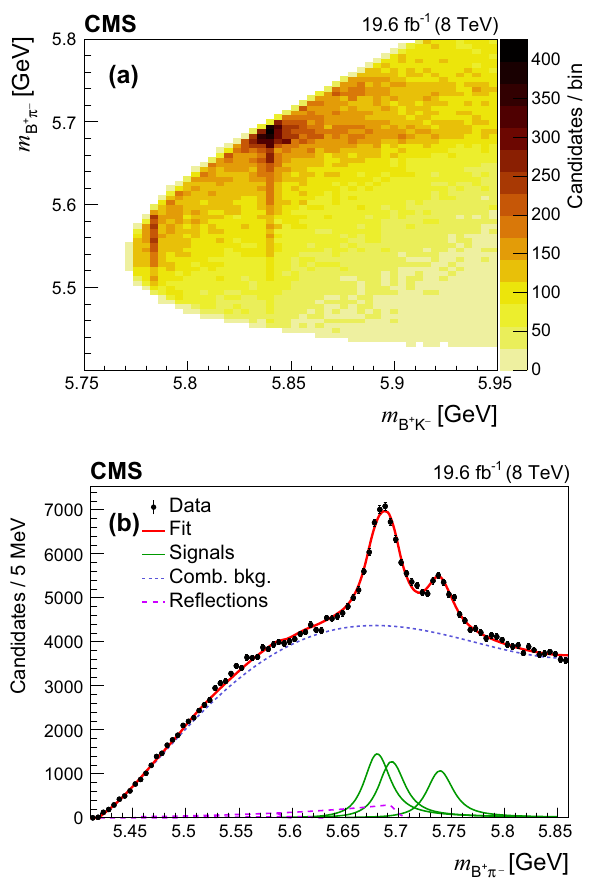
Fig. 2 a Two-dimensional distribution of m B + K − versus m B + π − in data. b The fitted B + π − invariant mass distribution. The points rep- resent the data, the thick solid curve is the fit projection, the thin lines indicatethethreeexcitedB 0 signalcontributions,theshort-dashedcurve is the combinatorial background, and the long-dashed lines show the contributions from the excited B 0 s decays